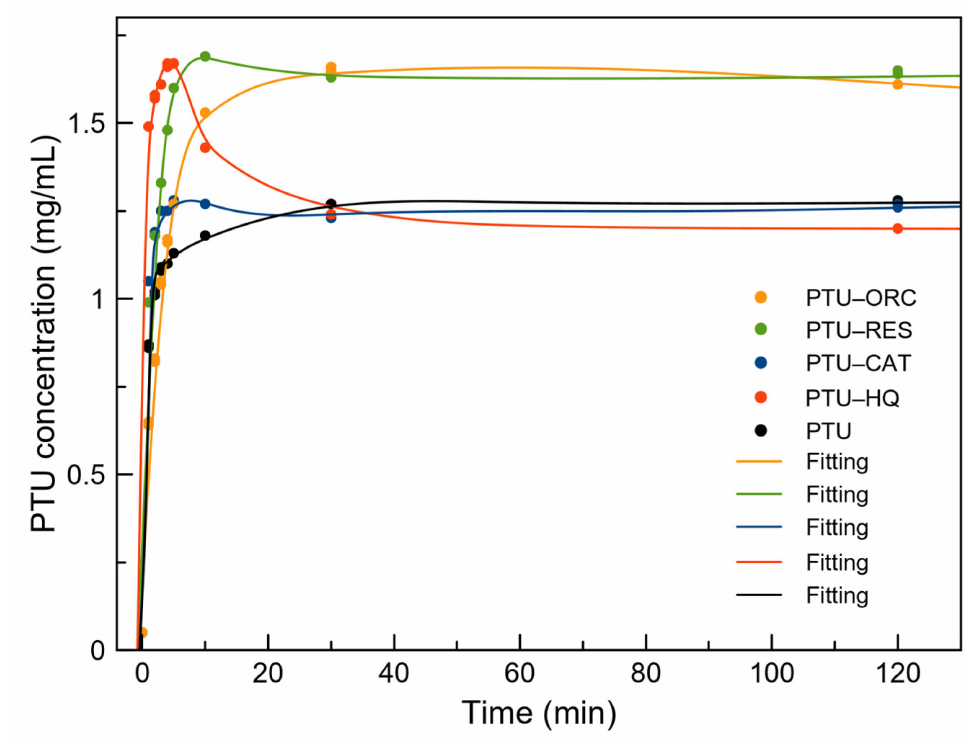
Figure 16. Powder dissolution profile of PTU and PTU cocrystals and the corresponding fitting curves (solid